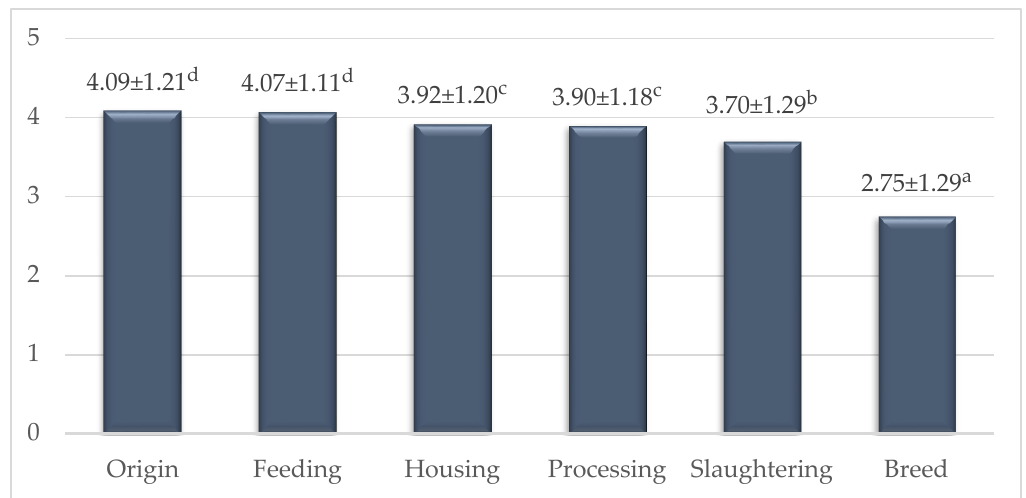
Figure 1. E ff ect of the production method and purchase form on buying decision (on a 1–5 scale). Figure 1. Effect of the production method and purchase form on buying decision (on a 1 – 5 scale). Mean ± SD; a–d means with di ff erent superscripts di ff er ( p < Mean ± SD; a – d means with different superscripts differ ( p < 0.05).